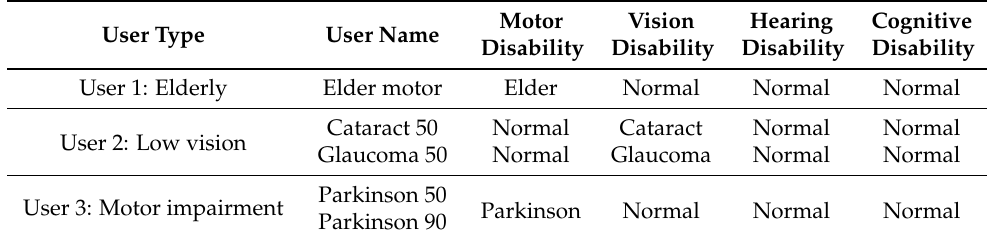
Table 1. Virtual user models created to test accessibility.